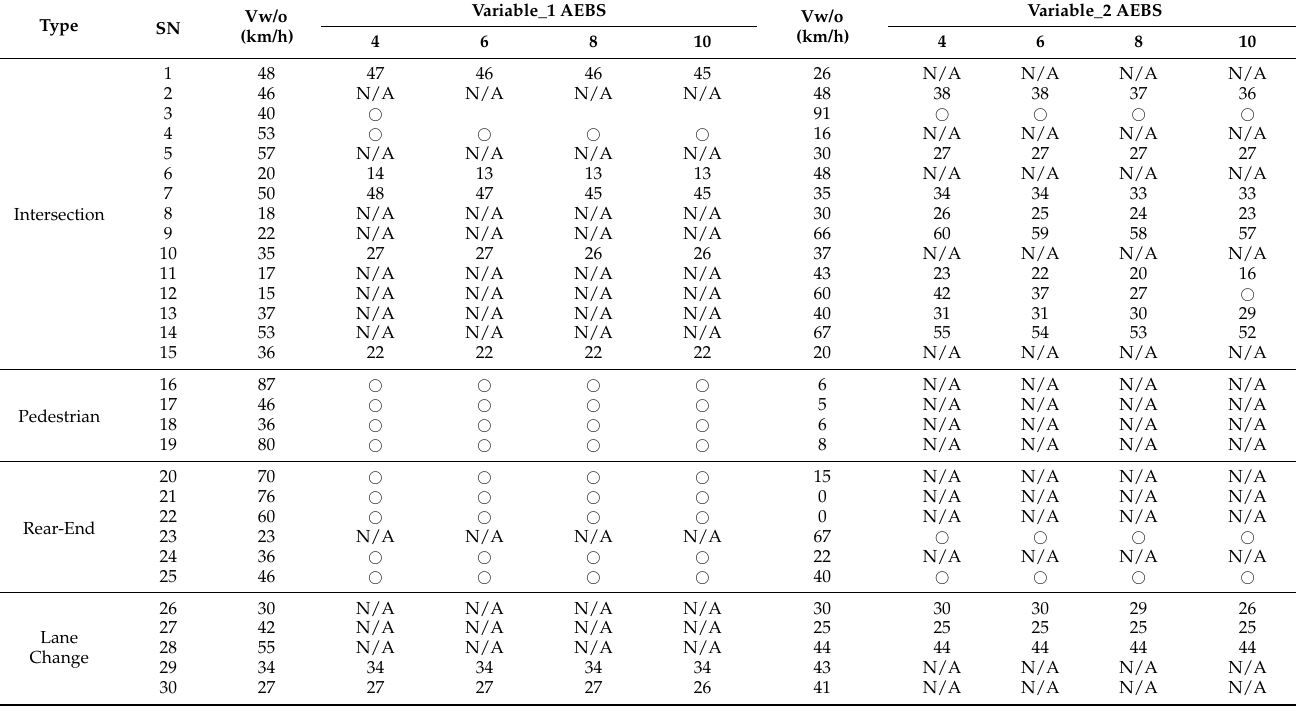
Table 5. AEBS results applied in real